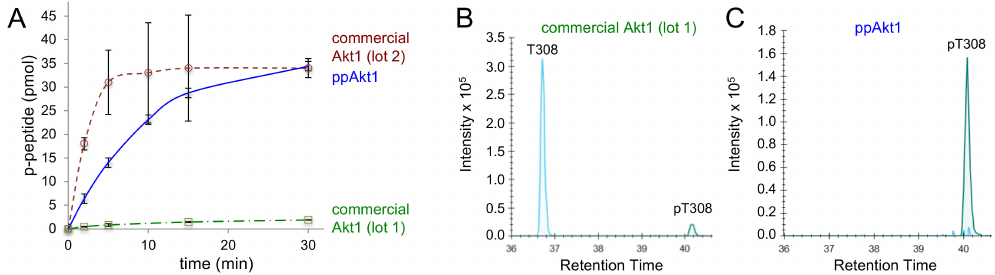
Figure 3. Activity of full-length ppAkt1 and commercially available active Akt1. ( A ) Kinase activity assays over a 30 min time course show substantially reduced activity of commercial Akt1 (lot 1, green squares) compared to full-length ppAkt1 (blue diamonds) produced in E. coli . Commercial Akt1 lot 2 (red circles) showed highly variable but similar activity to full-length ppAkt1. ( B ) Tryptic peptides from commercial Akt1 and ppAkt1 were analyzed by parallel-reaction monitoring mass spectrometry (PRM-MS). The purchased active Akt1 (lot 1) showed a low-intensity peak for phosphorylation at Thr308 (green peak at a retention time of ~40 min) and high-intensity peak for non-phosphorylated Thr308 (cyan peak, retention time of ~37 min). ( C ) PRM-MS analysis of ppAkt1 T308,S473 showed a high-intensity peak for phosphorylation at Thr308 (green peak at a retention time of 40 min) and the non-phosphorylated Thr308 was undetectable.